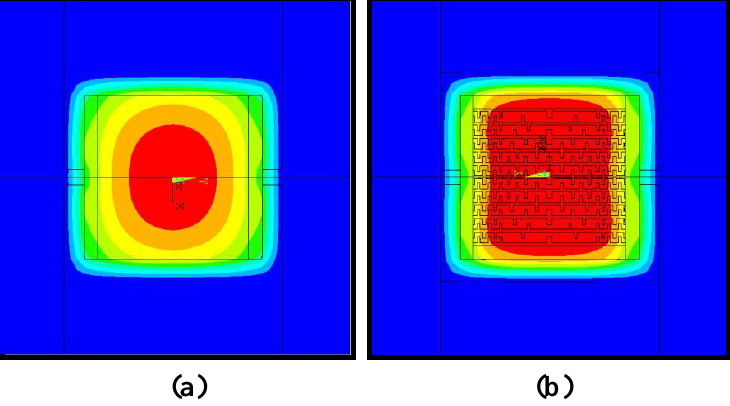
Figure 3. Analyzed heating characteristics of micro-heaters by FEM